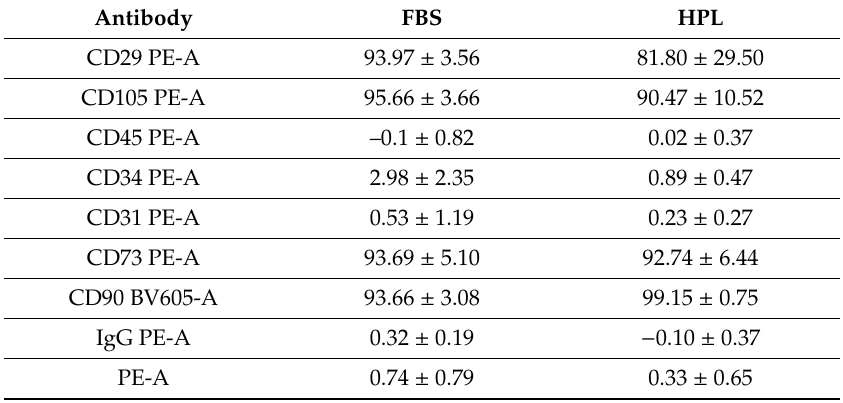
Figure 2. Histograms of flow cytometry detection of surface antigens. The ASCs were culture expanded in stromal media containing either 10% FBS or 0.75% PL and the expression determined for the following surface antigens by flow cytometry: CD29, CD31, CD34, CD45, CD73, CD90, and CD105, with IgG serving as a negative control. The histograms displayed are all derived from a single individual ASC donor and are representative of n = 3 donors. CD: cluster of differentiation. Table 2. Immunophenotype of adipose derived stromal / stem cells following expansion in 10% FBS or 0.75% HPL.